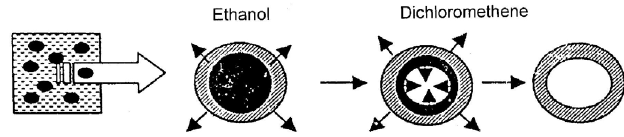
FIGURE 2 - Formulation of floating microspheres (Kawashima et al ., 1991).